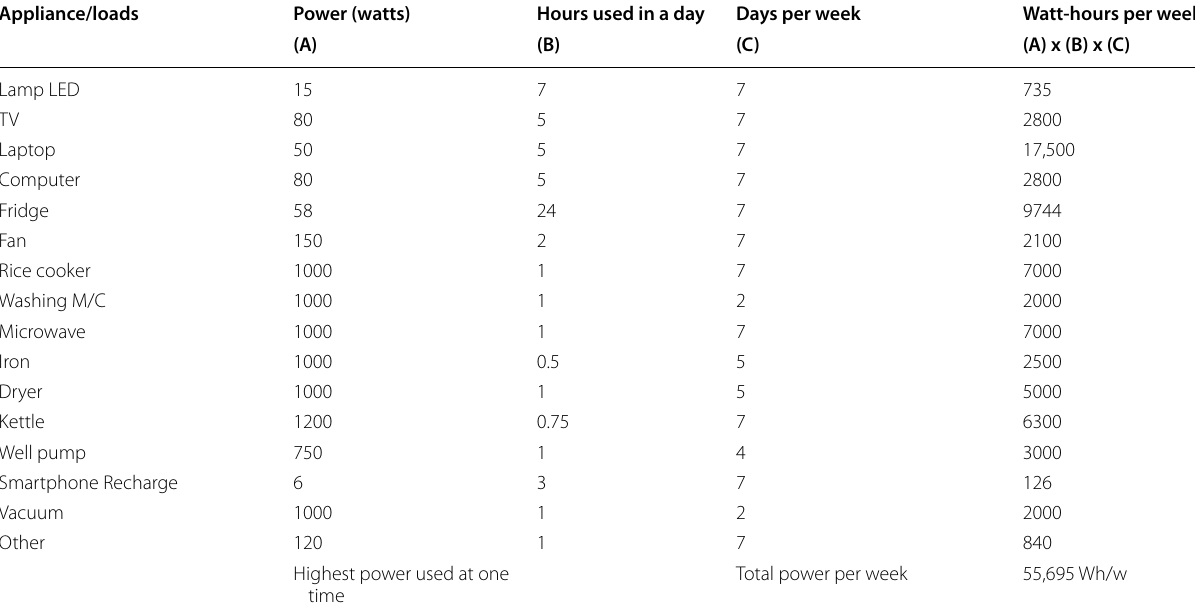
Table 3 The load profile of a typical household in Kathmandu Appliance/loads